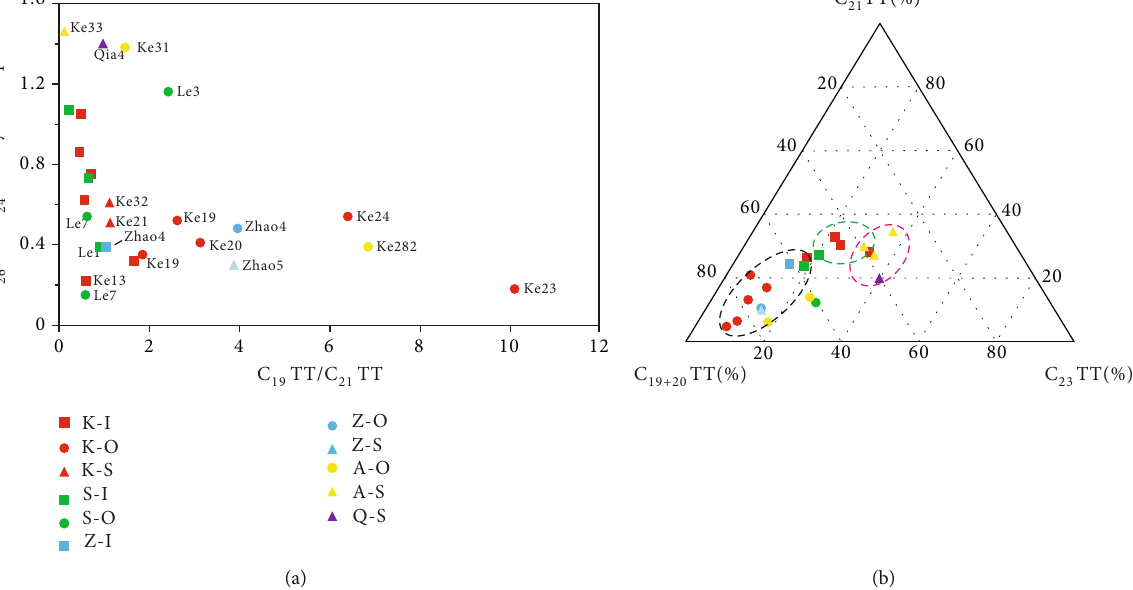
TT/C TT and C TT/C tetracyclic terpanes. (b) Percentage of C 19 21 26 24